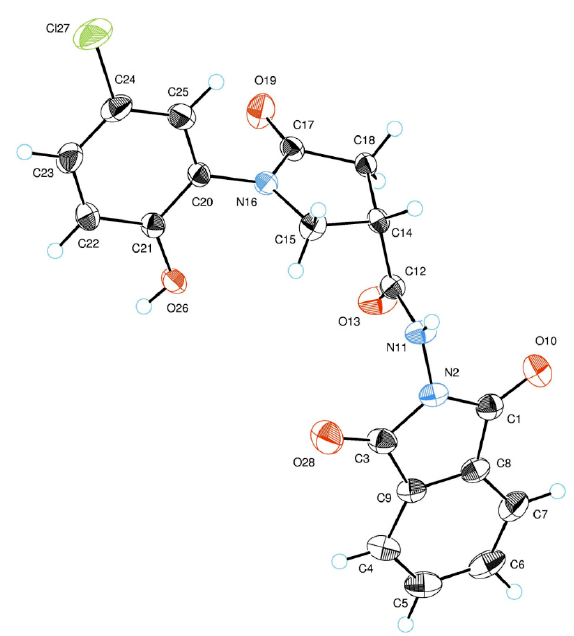
Figure 1. ORTEP (Oak Ridge Thermal-Ellipsoid Plot Program) molecular structure of 11 , showing the atom-numbering scheme. Displacement ellipsoids are drawn at the 50% probability level and hydrogen atoms are shown as small spheres of arbitrary radii.